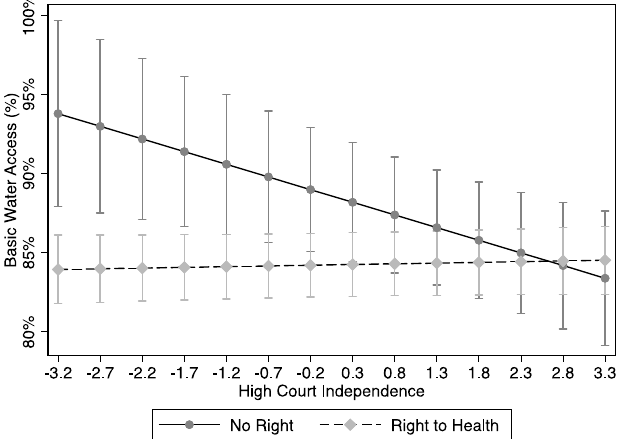
Figure 6. Marginal Effects of High Court Independence and Right to Health and Water on Access.